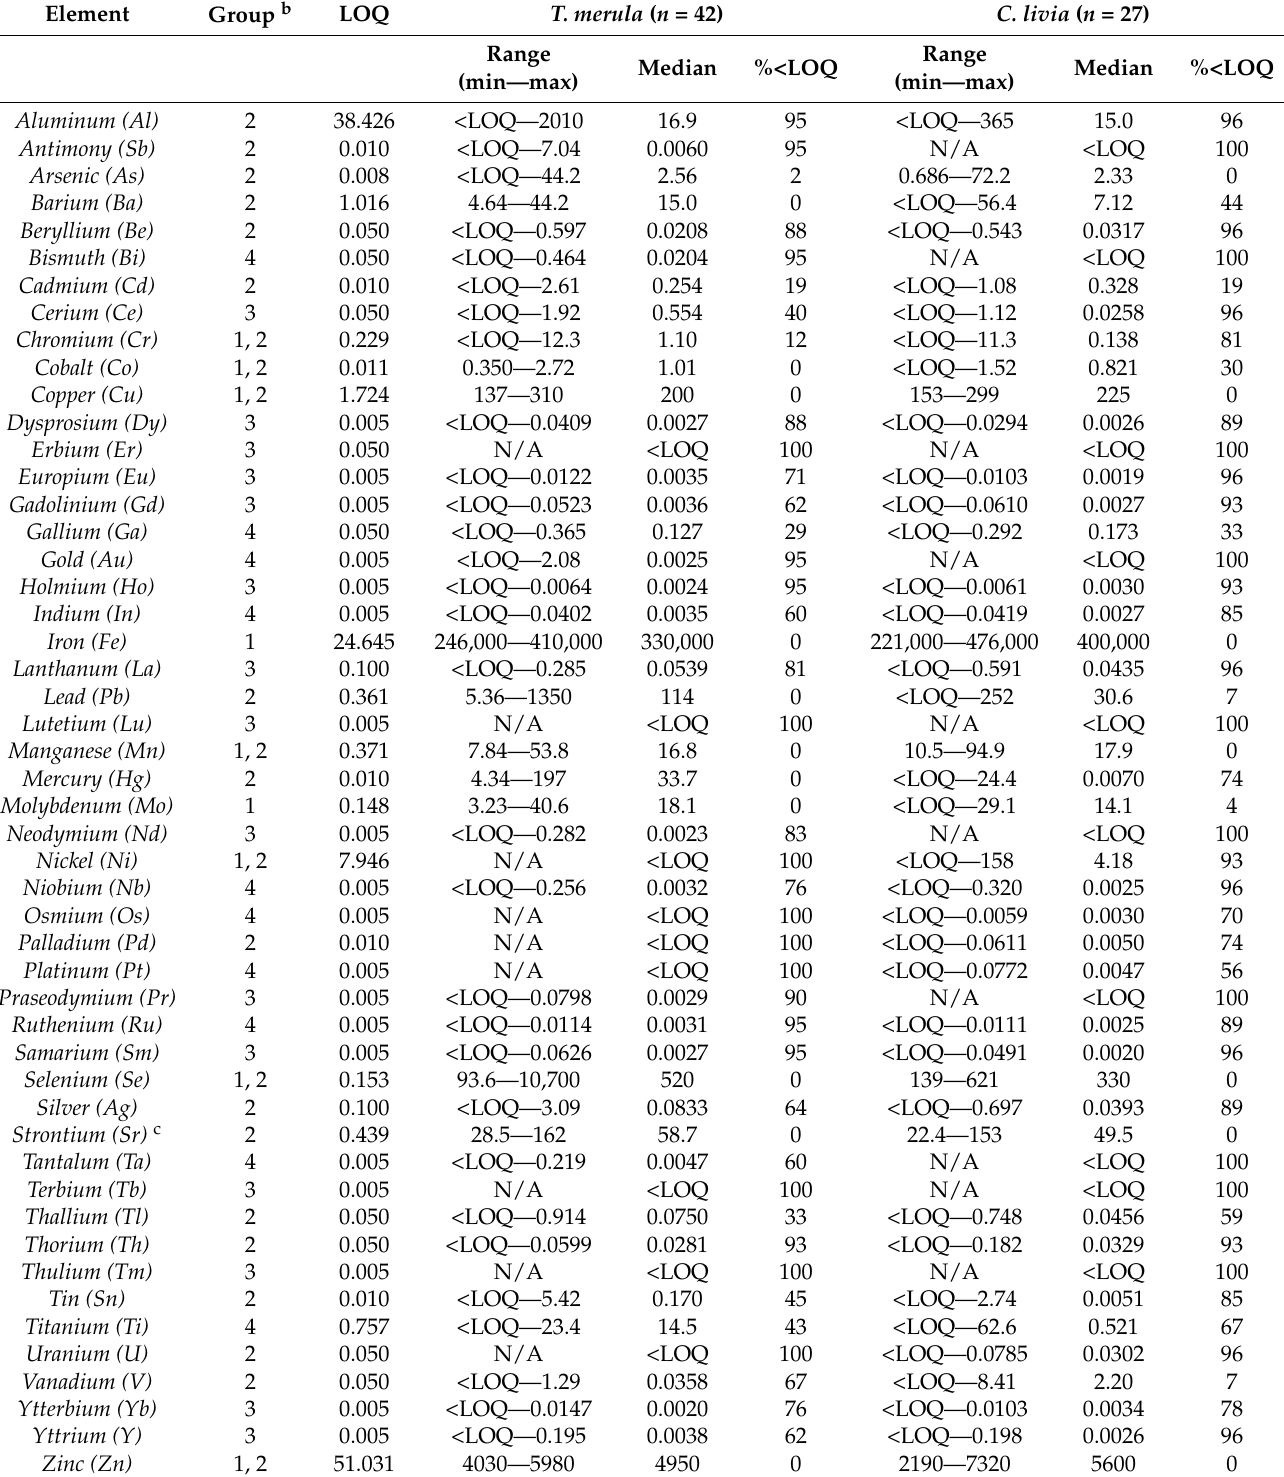
Table 1. Ranges and medians for element concentrations a (ng/mL, w.w.) in whole blood of the Eurasian blackbird ( Turdus merula ) and wild rock pigeon ( Columba livia ). Limits of quantification (LOQ) given together with the proportion of samples